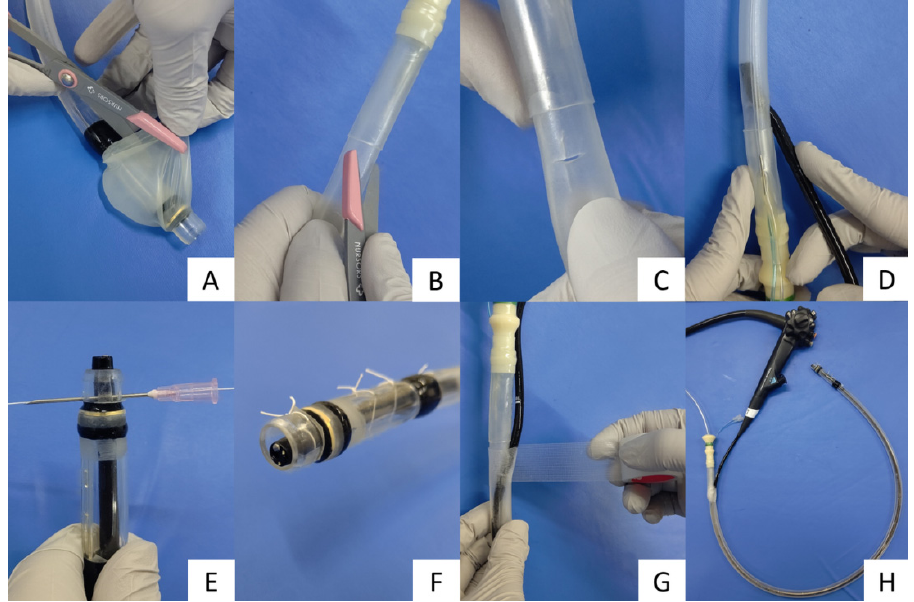
Figure 2. Procedure for creating a gastric residue suction device. ( A ) Remove the overtube-mounted balloon section using scissors. ( B , C ) Make a 10 × 10 mm cross incision with scissors 10 cm from the base of the overtube. ( D ) Insert the ultrathin endoscope into the tube through the cross incision. ( E , F ) Fix the scope to the tube with silk thread 2 mm from the distal tip. ( G ) Reinforce the cross- incision with vinyl tape. ( H ) Connect the suction tube to the base of the overtube.